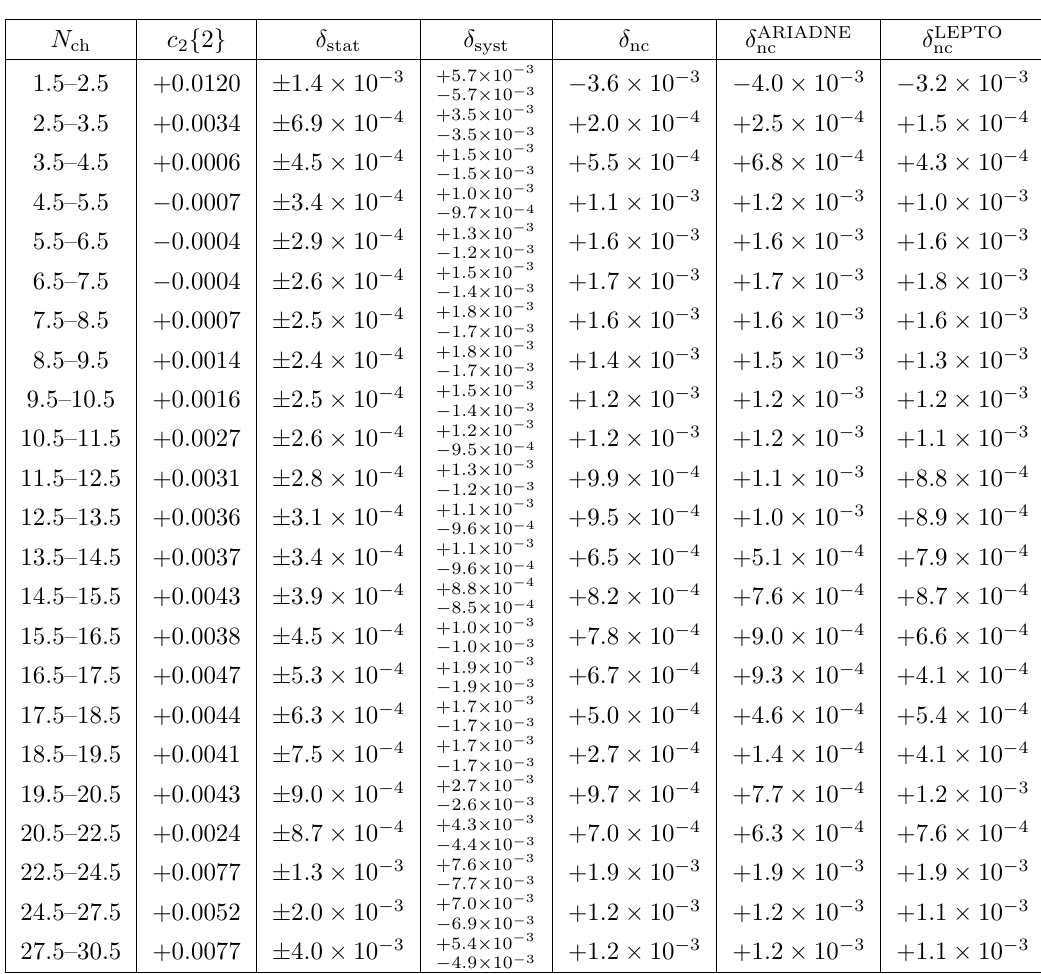
Table 5 . c 2 f 2 g versus N ch from (cid:12)gure 7 (b), p T > 0 : 1 GeV, j (cid:1) (cid:17) j > 2; (cid:14) stat , (cid:14) syst and (cid:14) nc denote the statistical, systematic and Monte Carlo non-closure uncertainties,